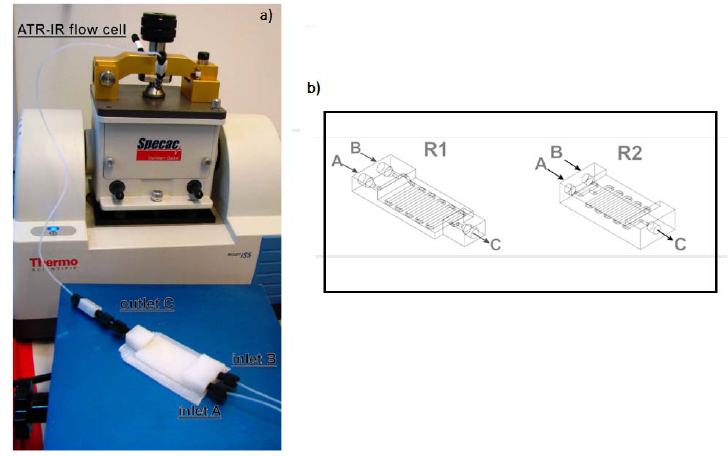
Figure 7. (Dragone et al.) ( a ) Flow system setup; ( b ) Schematic representation of the 3D ‐ printed reactionware devices with two inputs and one output, showing the internal channels. The dimensions of the inlets/outlets are 3 mm in R1 and 6 mm in R2. (Reproduced with permission from [32].)